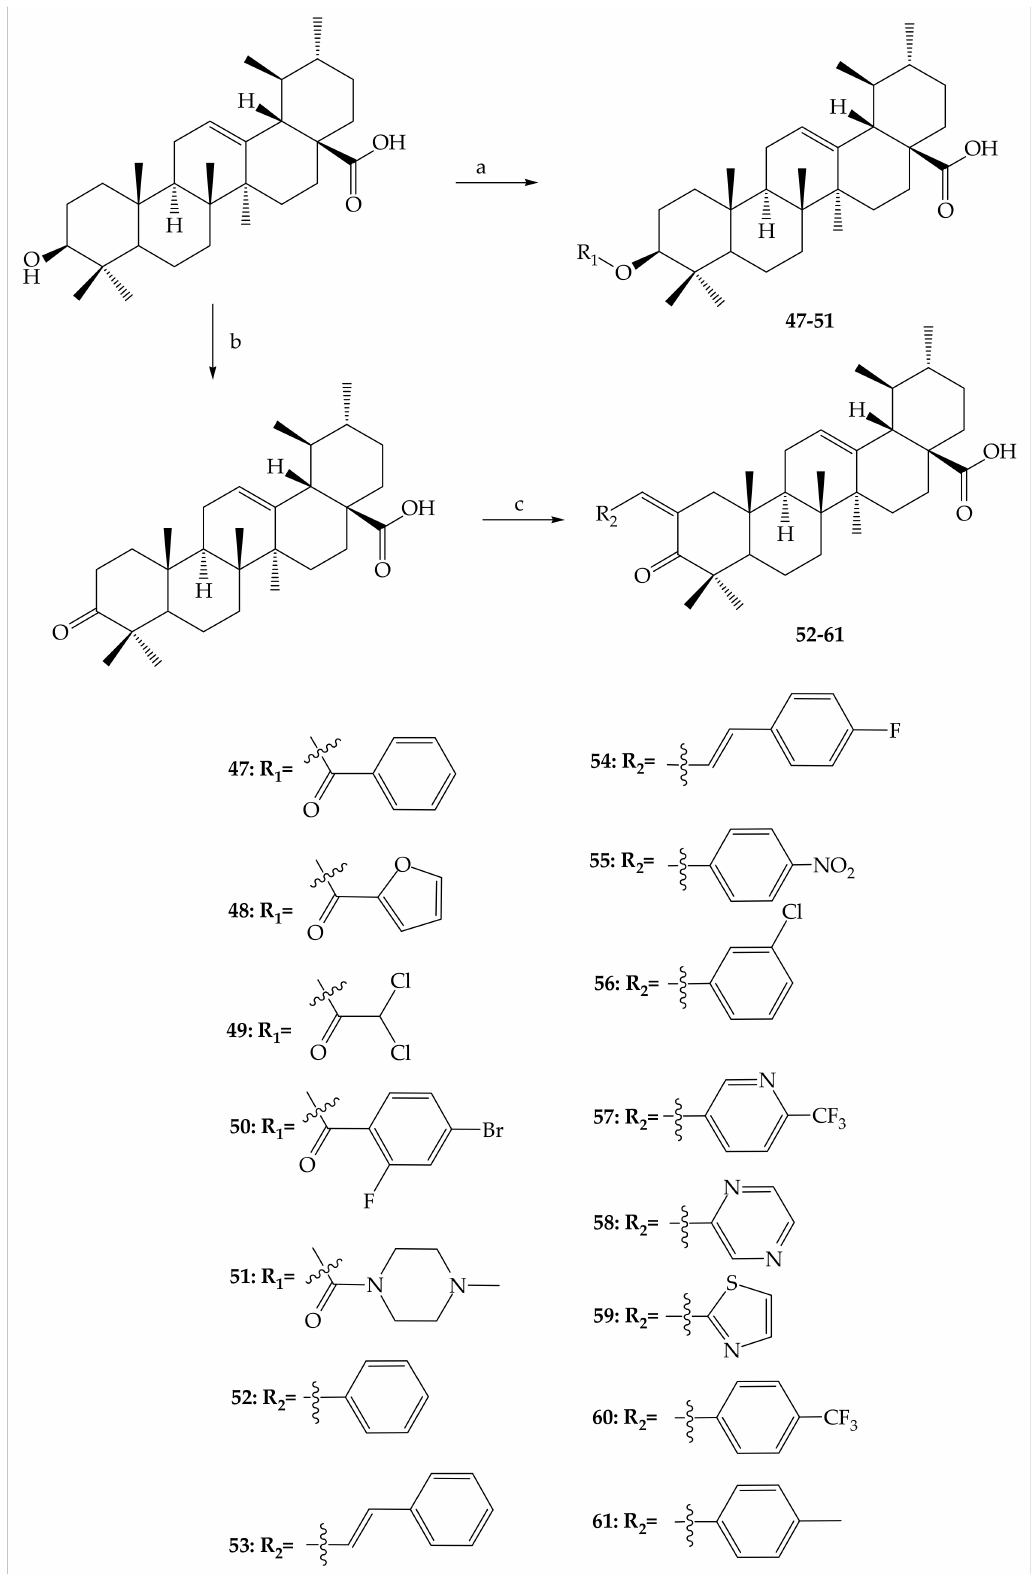
Figure 8. Synthesis of UA derivatives; reagents and conditions: (a) acid chloride or anhydride, DMAP, pyridine, reflux; (b) chromium (III) oxide (CrO 3 ), sulphuric acid (H 2 SO 4 ), acetone, 0 ◦ C, 1 h; (c) R1-CHO, potassium hydroxide (KOH), ethanol, room